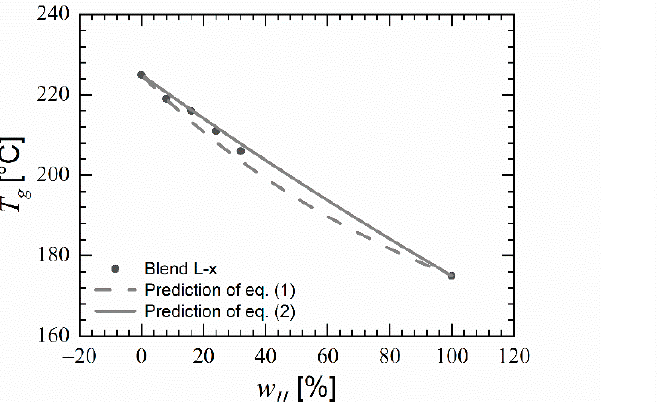
Figure 2. Heat flow versus temperature in second heating of blend L-32 showing single glass transition.